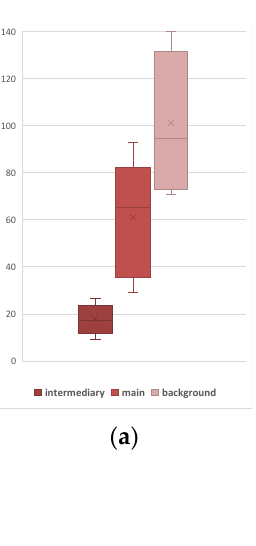
( c ) Figure 19. Correlation between the area of the triangle in CIELAB color space and the lightness (L) ( a ) of the main (m), ( b ) “intermediary” (i), and ( c ) background ( b ) colors. 6. Conclusions Our CIELAB color space study of the color triads selected by Matyushin for the Ref- erence Book of Color allows a number of important conclusions about the chromatic charac- teristics of colors (hue, chroma, and lightness) and their combination criteria. Chromatic characteristics of colors . The Reference Book ’s triads contain those colors that Matyushin and his disciples subjected to thorough experimental study in the GINK- hUK laboratory. For his main colors, Matyushin selects deep, high-chroma shades that are fairly evenly distributed in the quadrants of the color circle. These are as follows: red, orange, yellow, yellow-green, light blue, blue, and purple. The charts’ environmental background colors, as a rule, are complementary to the main colors, and on the color circle are located opposite or almost opposite their